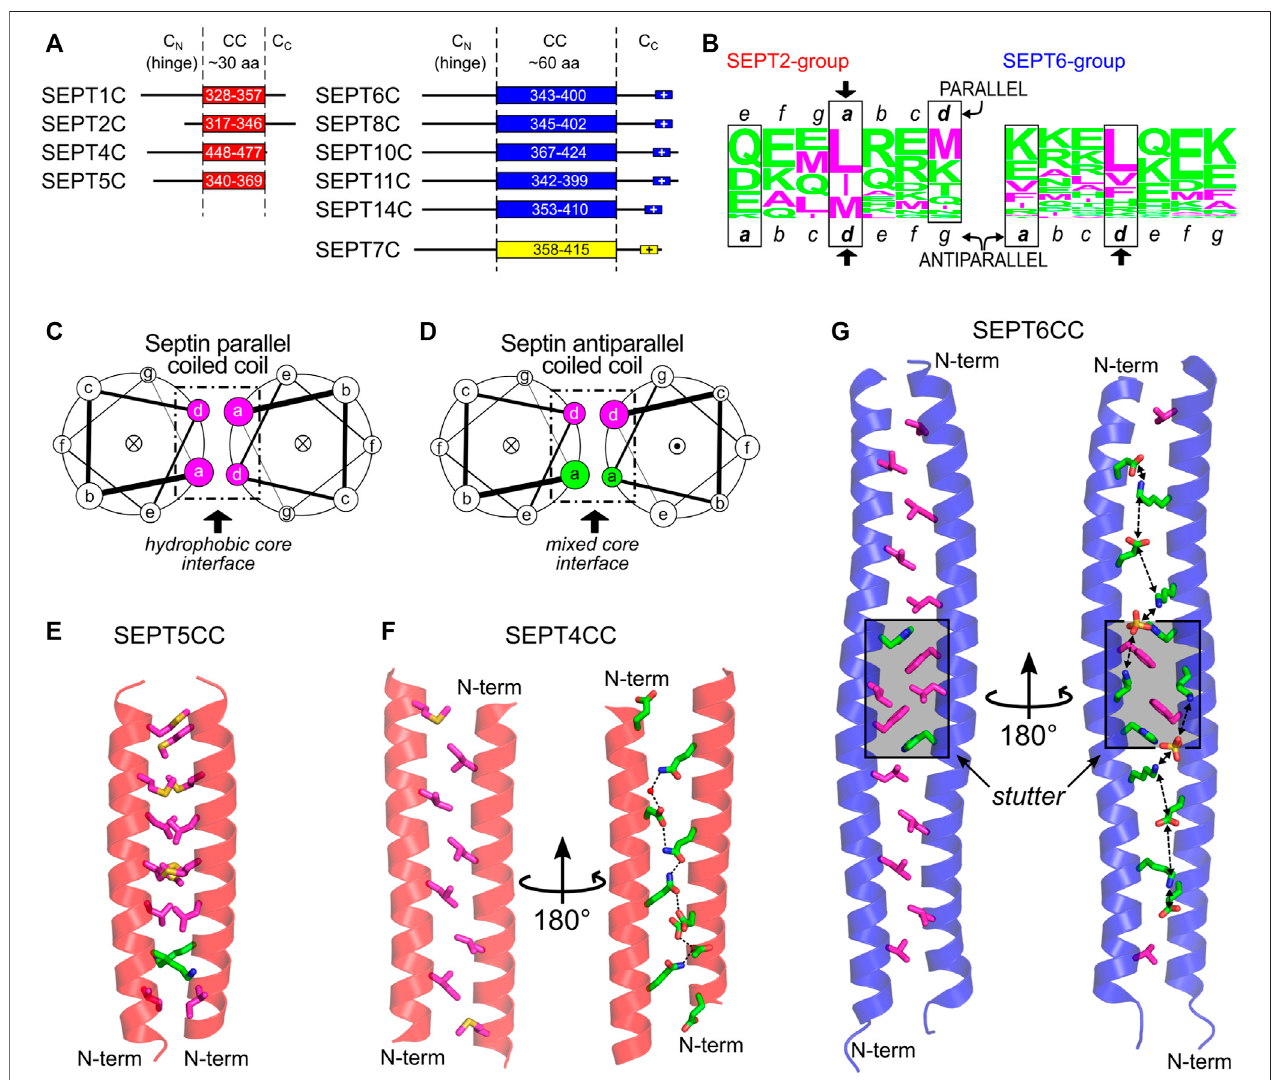
FIGURE10| TheC-domainand the septincoiled coils. (A) C-domain elements inSEPT2- (red), SEPT6- (blue) and SEPT7-groupmembers(yellow) asreported by Leonardo et al. (Leonardo et al., 2021). The following Uniprot entries were used for residue numbering: SEPT1, Q8WYJ6; SEPT2, Q15019; SEPT4, O43236; SEPT5, Q99719;SEPT6, Q14141-2; SEPT7, Q16181;SEPT8, Q92599-2; SEPT11,Q9NVA2; SEPT14, Q6ZU15. (B) CC heptadmotifsinmembers ofhumanSEPT2 (left) and SEPT6 group (right) represented using a residue frequency sequence logo. Identi fi ed core positions are highlighted in boxes and register assignment is shown as seen in the X-ray structures. General helical wheel schemes for (C) parallel and (D) antiparallel human septin coiled coils, showing the different chemical composition of residuesinthecore( a and d positions).Thedot( C )orcross( × )insidethecirclesrepresentthehelixdirection,outward-andinward-pointing,respectively. (E) Theparallel septincoiledcoilofSEPT5fromtheSEPT2group(PDB:6WCU)showingmainlyhydrophobic a and d sidechainresiduesassticks. (F) Theantiparallelseptincoiledcoilof SEPT4 from the SEPT2 group (PDB:6WB3) showing the two sides of the interface ( d -side, left; a -side, right) and the chain of hydrogen bonds seen on the hydrophilic side. (G) Antiparallel septin coiled coil of SEPT6 (PDB:6WBP) showing the two sides of the interface (as in panel (F) , but including the aromatic residue of the stutter, in both views) and the chain of favorable salt bridges seen on the hydrophilic a side. The stutter region is highlighted in grey. Throughout the fi gure, magenta and green colors represent hydrophobic and hydrophilic residues,